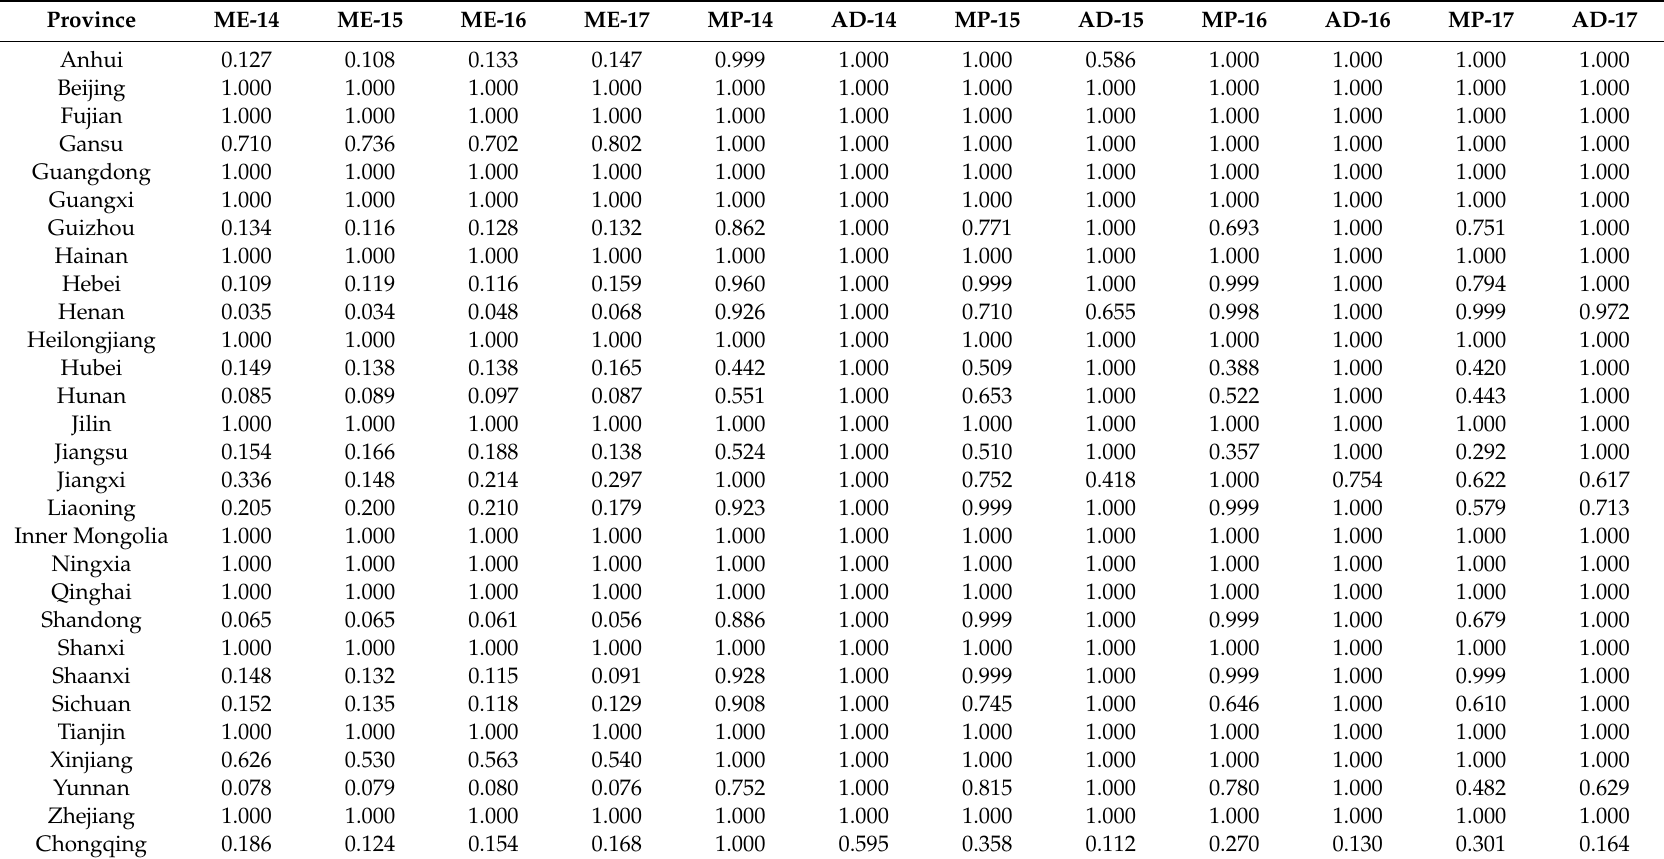
Table 5. Input and output e ffi ciencies in the mining production